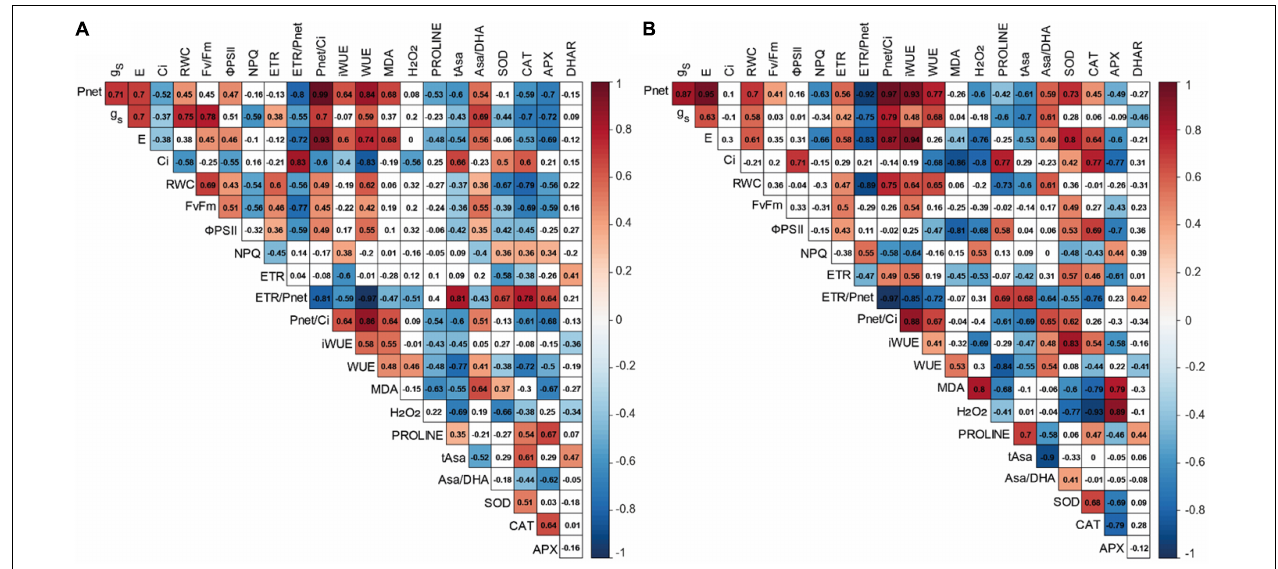
FIGURE 6 | Heat map of correlation matrix of physiological and biochemical variables found in (A) diploid and (B) triploid varieties under water deficit conditions. Correlation coefficient was calculated based on Pearson’s correlation at significant level ( α < 0.05). Red and blue colors indicate positive and negative effects, respectively. Color intensity is proportional to the correlation coefficients, according to the figure legend. The white square corresponds to non-significant correlation ( P -value > 0.05).